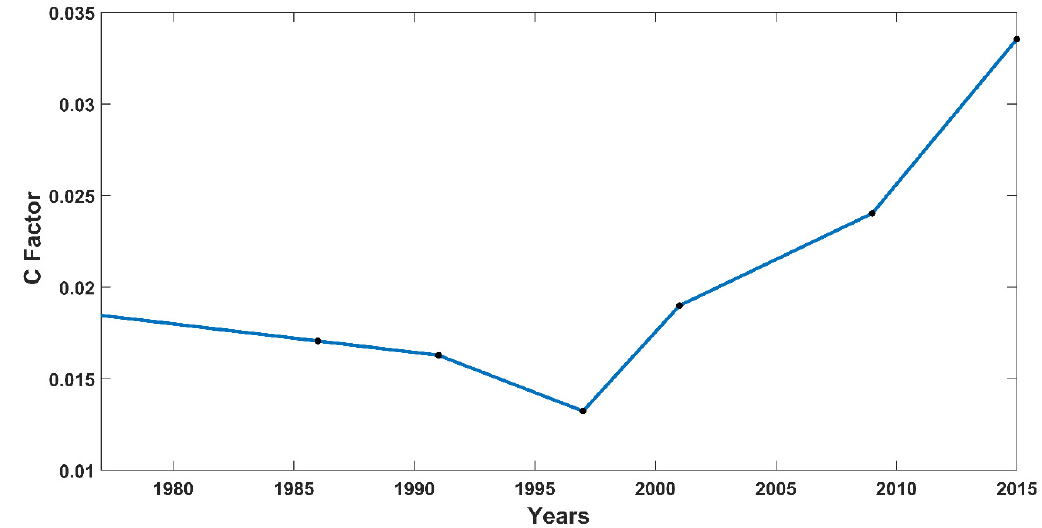
Figure 7. Temporal variability of the cover-management C factor, spatially averaged over the Tonusco River basin.